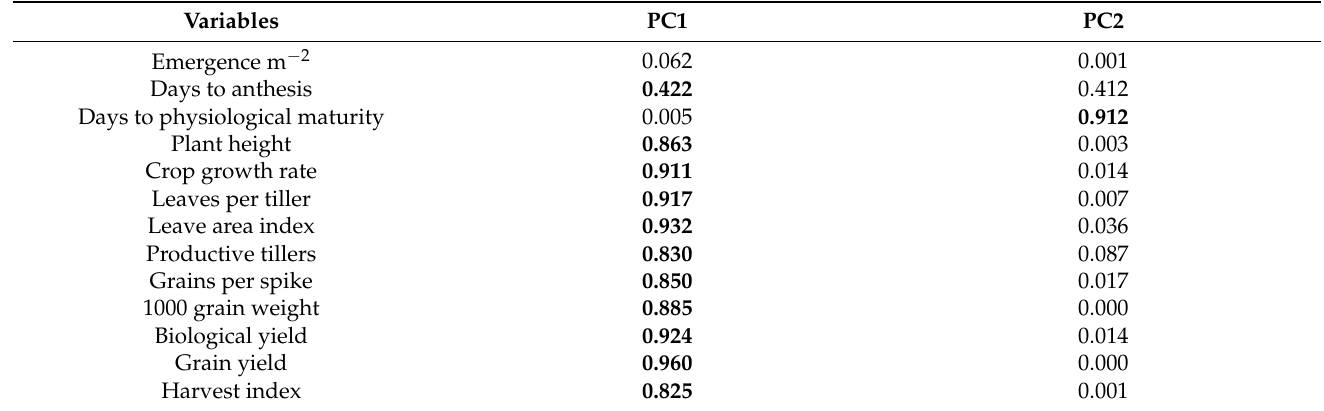
Figure 2. Principal components, eigenvalues, and explained variances from principal component analysis (PCA). F1, F2, . . . , Fn denote number of principal components. Table 6. Summary of the principal component analysis of the measured trails (Squared cosines of the variables).